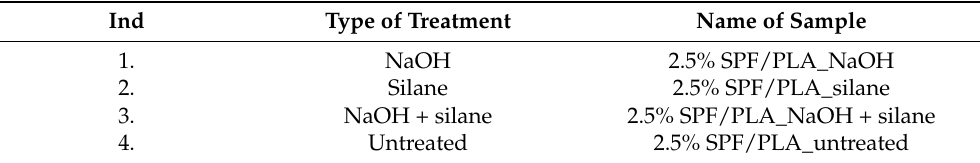
Table 2. List of